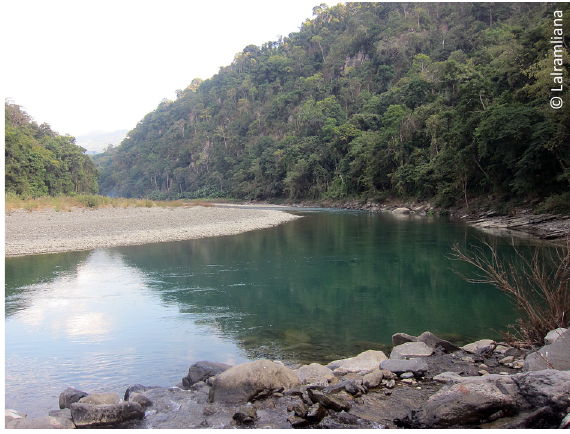
Image 4. Type locality of Eutropiichthys cetosus sp. nov.